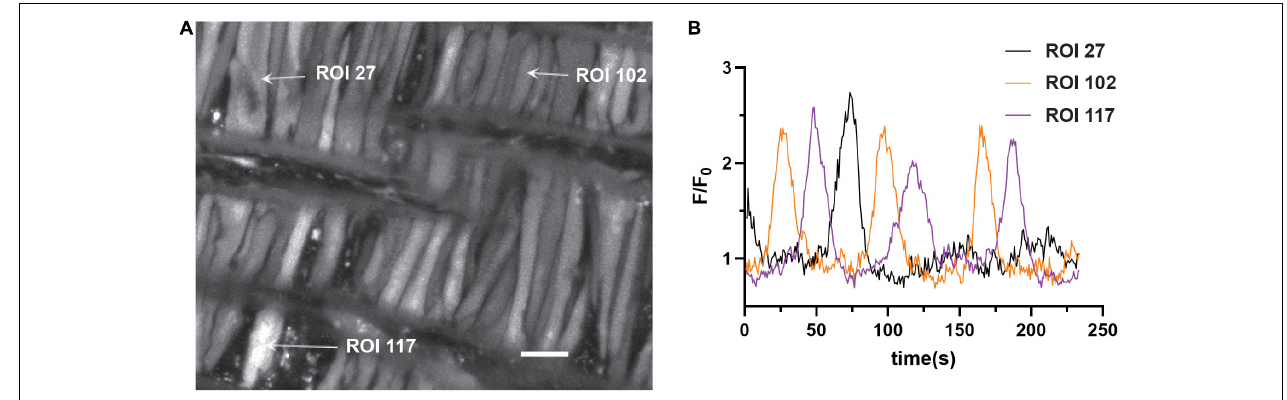
FIGURE 1 | Representative Ca 2 + responses in basilar arterial myocytes from an adult sheep recorded en face under 30K conditions. (A) maximum intensity projection for Fluo-4 fluorescence of recorded cells using laser scanning confocal microscopy. Arrows point to regions of interest in individual myocytes shown in (B) ; fluorescence intensity tracing showing spontaneous Ca 2 + oscillations in two ROIs. Scale bar (white) = 10 µ m.